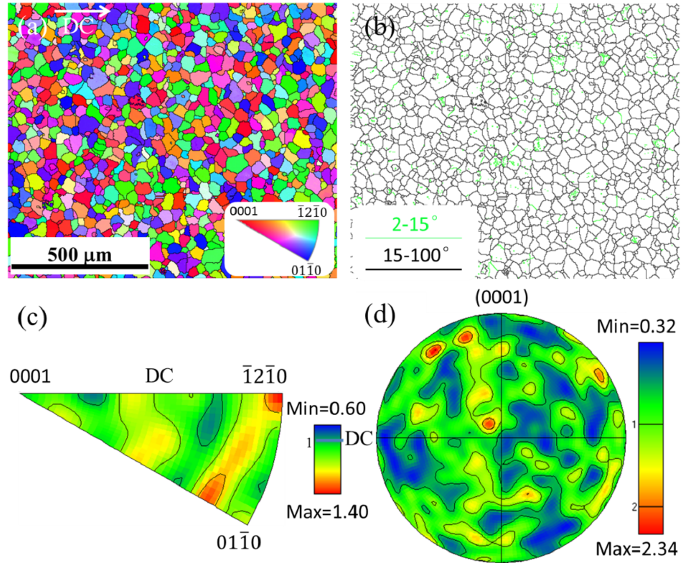
Figure 4. Inverse pole figure (IPF) map ( a ) of the as-cast (AC) WE43 alloy along with its corresponding ( b ) boundary map, ( c ) typical IPF, and ( d ) (0001) basal pole figure (PF). The direct-chill casting direction (DC) is horizontal and the IPF map legend in picture ( a ) applies to all of the following IPF maps in this paper. The green and black color in picture ( b ) indicates the low and high angle grain boundaries, respectively (the same below). The color scale contours in pictures ( c ) and ( d ) represent multiples of a random distribution (similarly hereinafter).